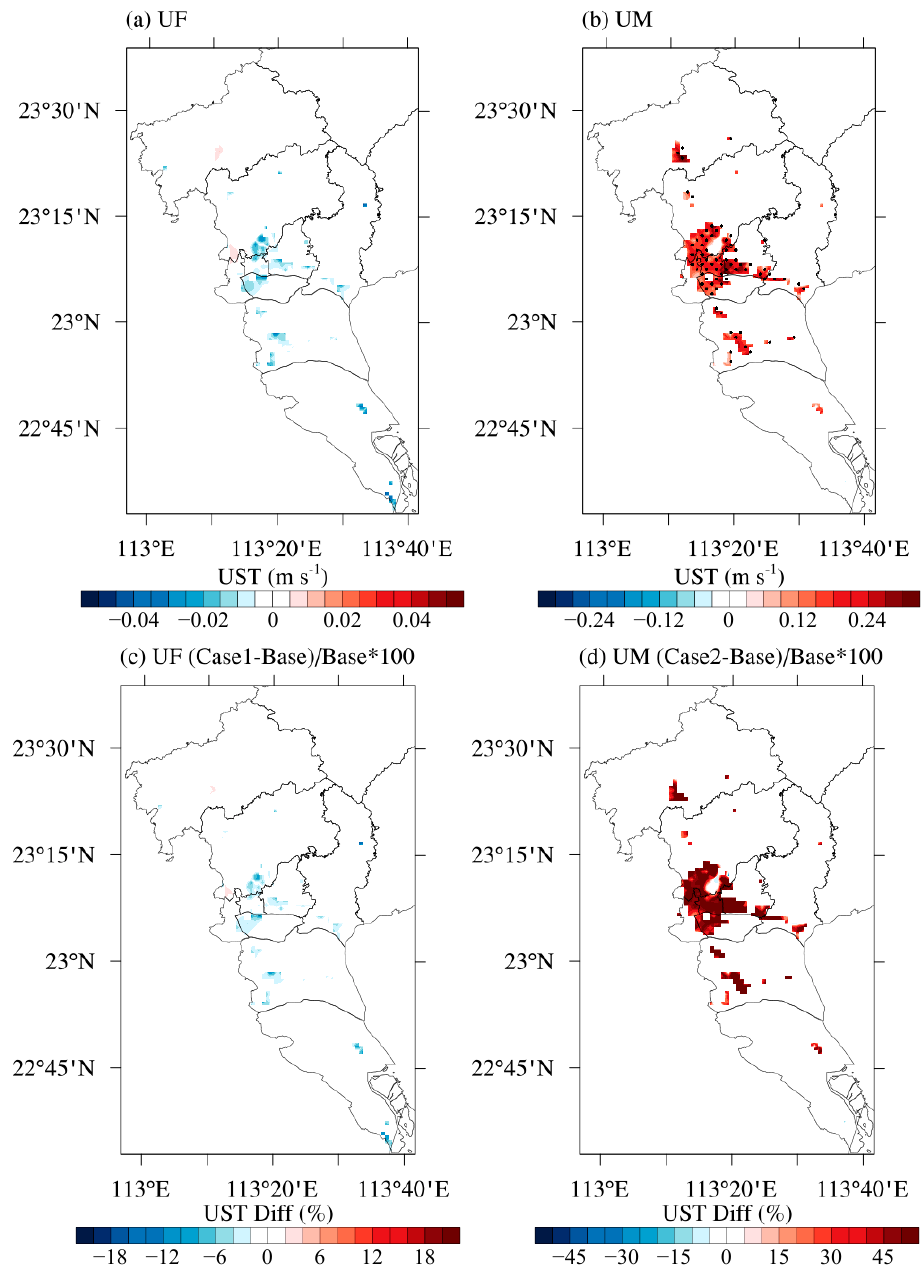
Figure 10. Impacts of the high-resolution UF and UM on the average friction velocity (UST) in the urban underlying surface of Guangzhou. Here, the impacts of UF/UM were calculated by comparing the simulated hourly UST values for 10 days (from 1 to 10 November) in two experiments and then averaging the result. ( a ) UF (Case 1—Base) impact; ( b ) UM (Case 2—Base) impact; ( c ) percentage change due to UF (Case 1—Base)/Base × 100; ( d ) percentage change due to UM (Case 2—Base)/Base × 100. In ( a , b ), statistically significant changes above the 99% confidence level are marked with black dots.